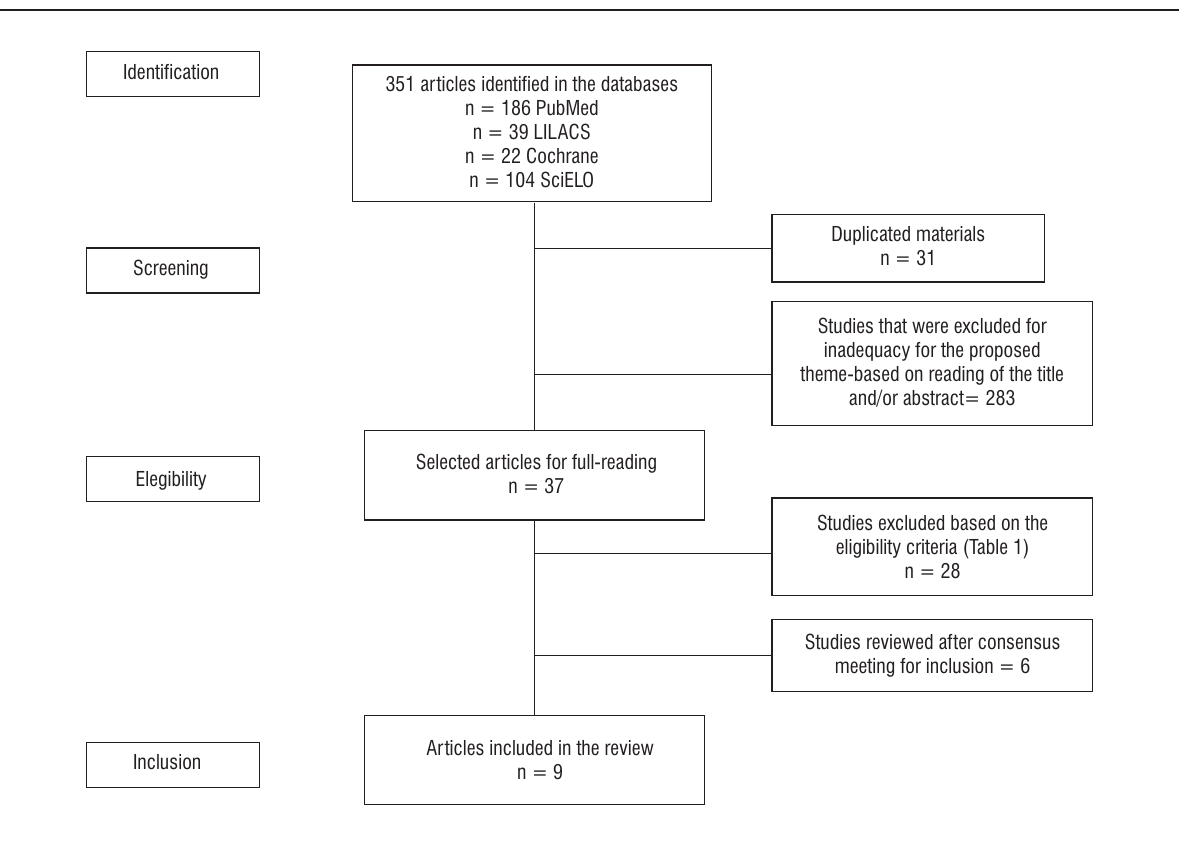
Figure 1 - Flow diagram of systematic review inclusion